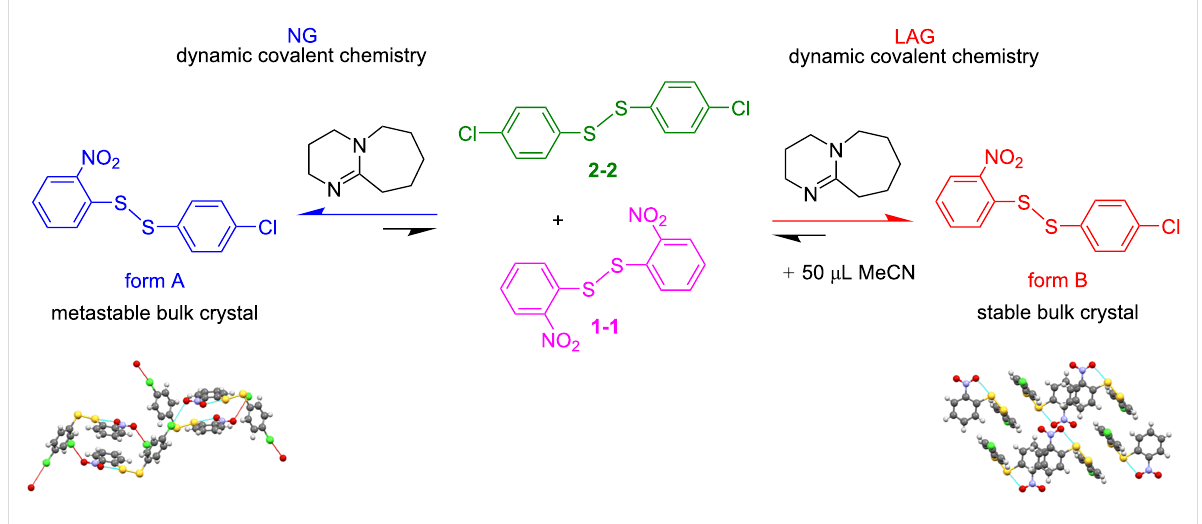
stable polymorph of the heterodimer, form A and form B respectively, crystallizes. The details of form A (CCDC code FUQLIM01) and form B (CCDC code FUQLIM) have been previously